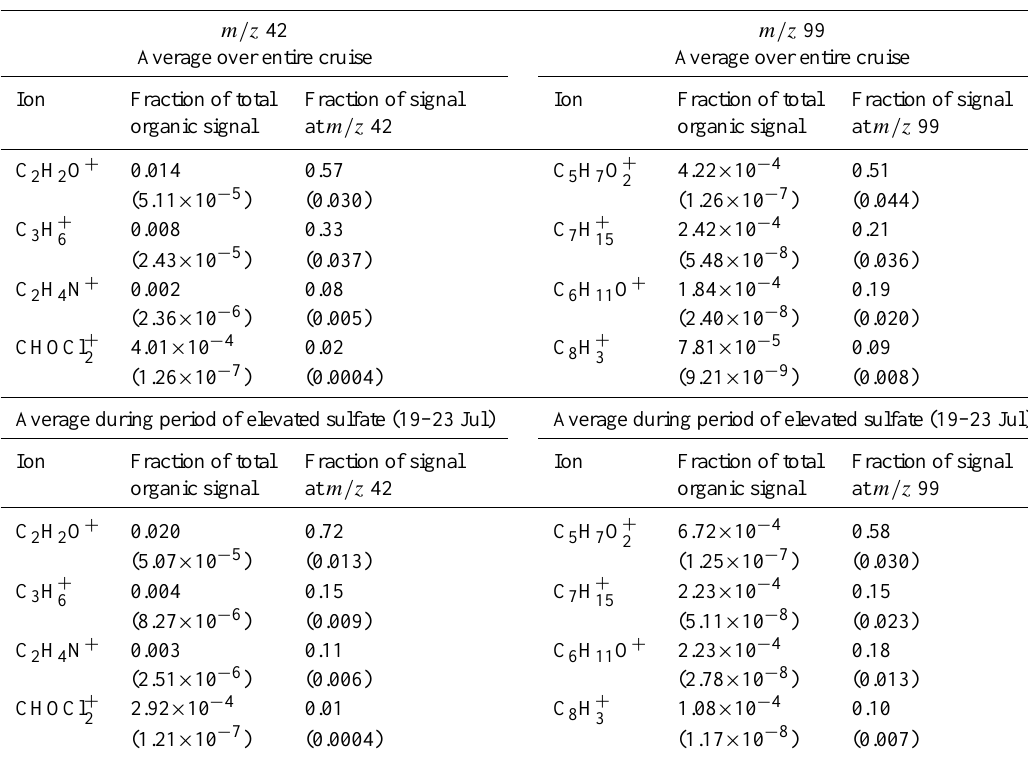
Table 4. Fraction of each ion at m/z 42 and m/z 99 over the entire R/V Point Sur cruise (top) and during periods of high sulfate loading (bottom). Values in parenthesis are the variance in the